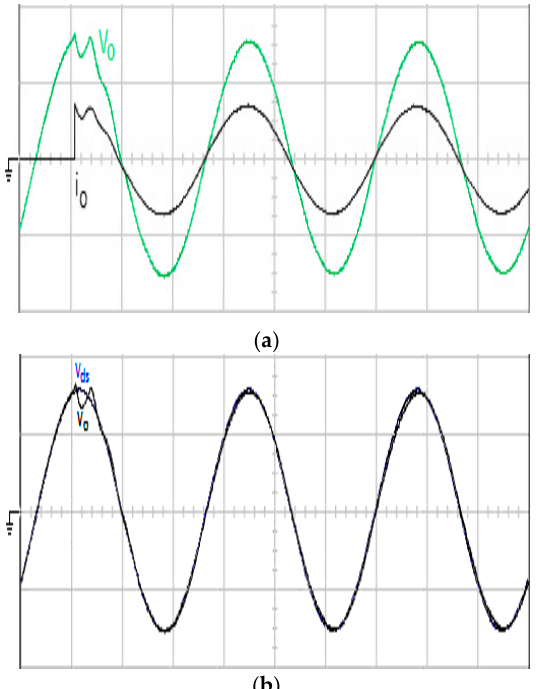
Figure 7. ( a ) Experimental waveforms of the output voltage and output current under step load change for the classical finite ‐ time convergent SMGL (100 V/div; 20 A/div; 5 ms/div); ( b ) Trajectories of output voltage and reference sine wave (100 V/div; 5